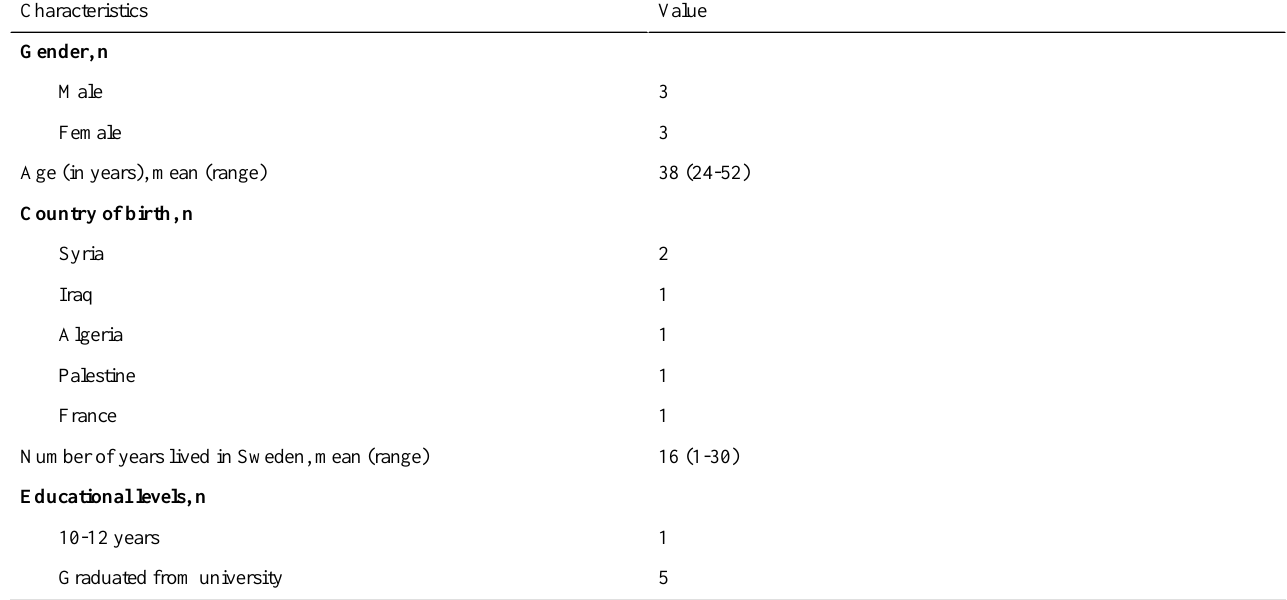
Table 1. Demographics of the test group